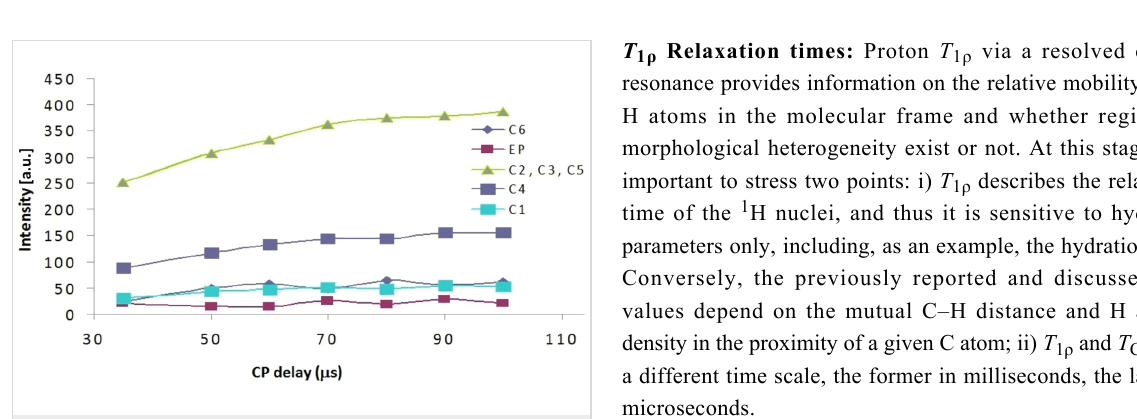
with close amounts of the imprinting agent. The polymer growth in the presence of increasing amounts of toluene leaves empty voids influencing the cross-polarization rate in terms of average C–H distances, H atoms density in the proximity of the observed C and the local dynamics. The data thus point out that T CH can be used as a descriptor to differentiate polymers with the same chemical structure and not showing any spectral differences, as shown by the spectra of Figure 3 where no chemical shift variations can be detected, but indeed differently imprinted by